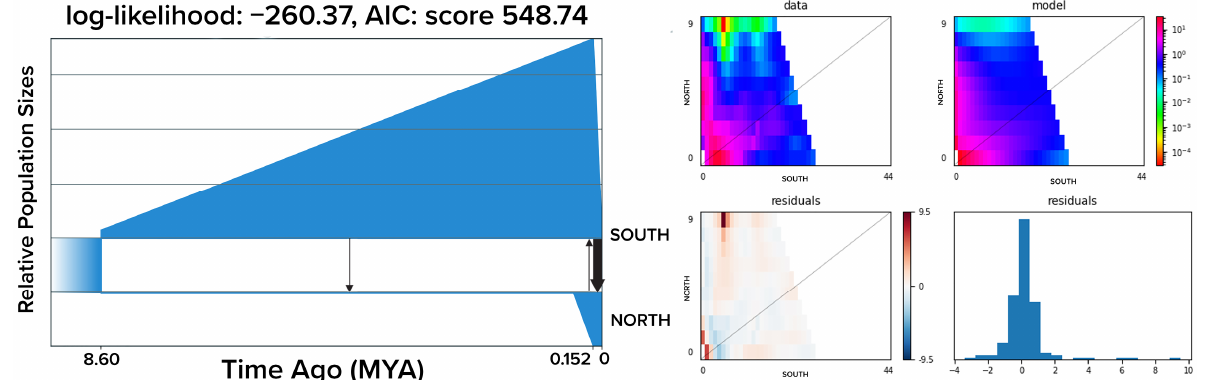
Figure 3. GADMA model selected ( left ) and model validation ( right ). On the graph depicting the